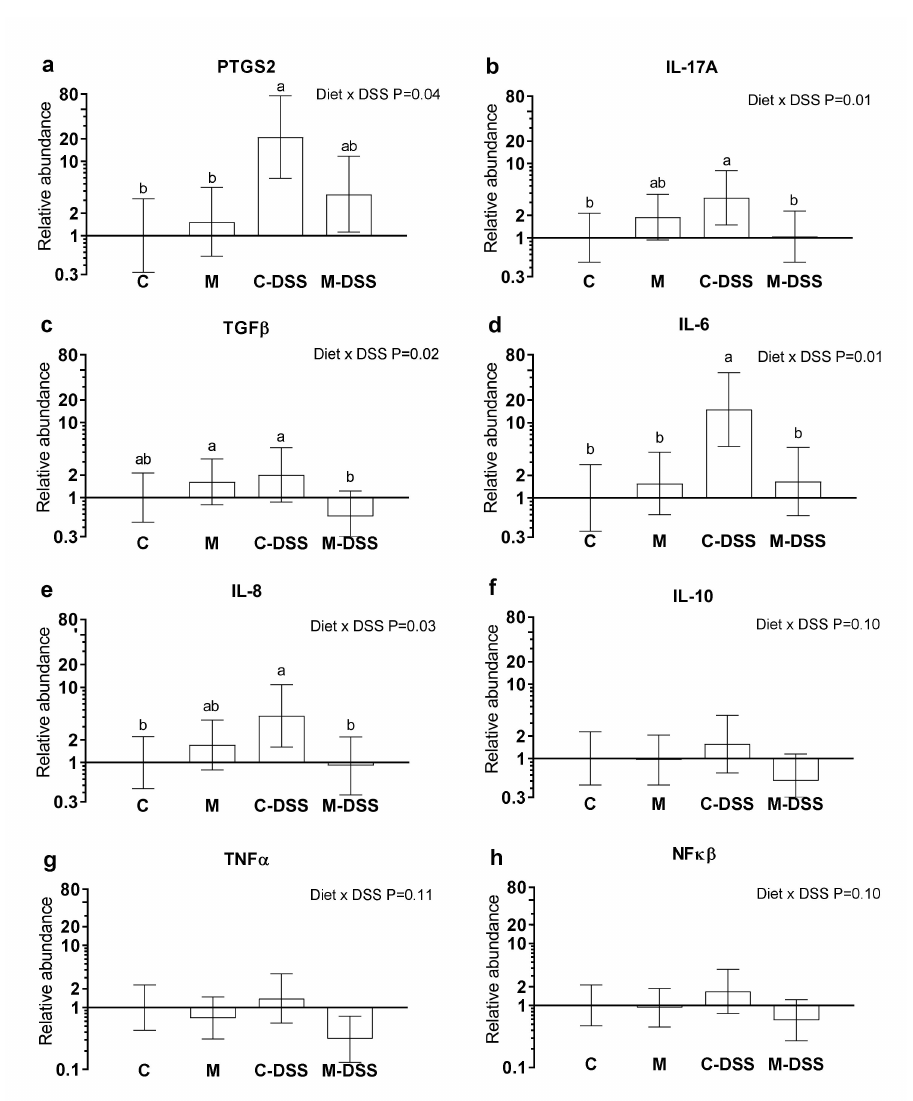
Figure 4. Relative mRNA abundance in the colon of pigs fed the control diet (C), the meat diet (M), the control diet + DSS (C-DSS) or the meat diet + DSS (M-DSS) ( n = 6 / group except C-DSS n = 5). ( a ) PTGS-2; ( b ) IL-17A; ( c ) TGF β ; ( d ) IL-6; ( e ) IL-8; ( f ) IL-10; ( g ) TNF α ; ( h ) NF κβ . Data are presented